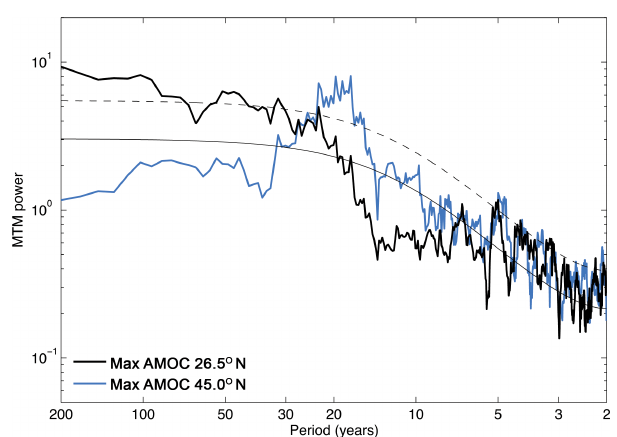
Fig. 22. Power spectrum of time series of annual maximum AMOC at 26.5 ◦ N (black line) and 45 ◦ N (blue line) using the multitaper method of Ghil et al. (2002) with resolution p =4 and number of tapers t =7. The thin black line represents a fitted red noise spectrum of the 26.5 ◦ N maximum AMOC spectrum and the dashed line the 95% confidence limit about the red noise spectrum.